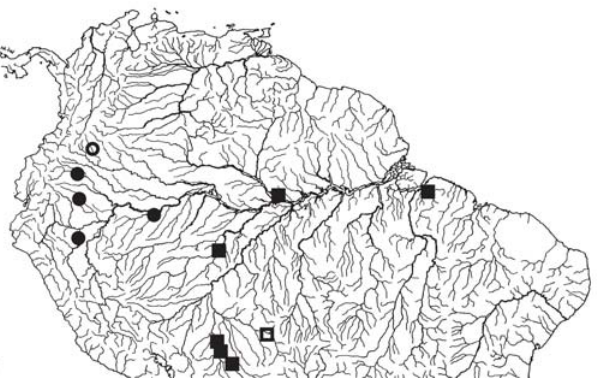
Fig. 4. Localities for Pterygoplichthys punctatus (squares) and P. weberi (dots). Open symbols are type localities. Lo- calities for P. punctatus from Weber (1992) and specimens examined in this study. Because the rio Urubu locality of P. punctatus did not have precise locality information, the lo- cality is indicated at random in the lower Urubu. Base map by M. J.